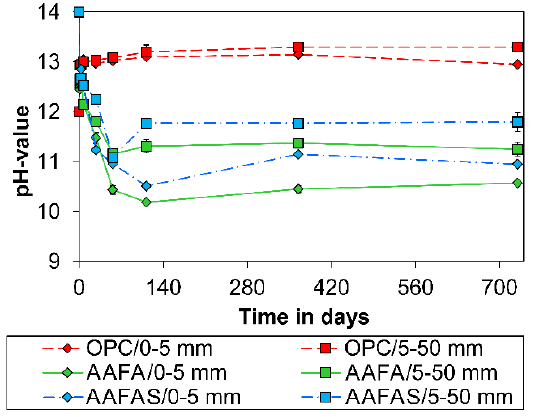
Figure 4. Development of pH value at different depths in concrete under 20 °C/65% rH/0.04 Vol.-% CO 2 .